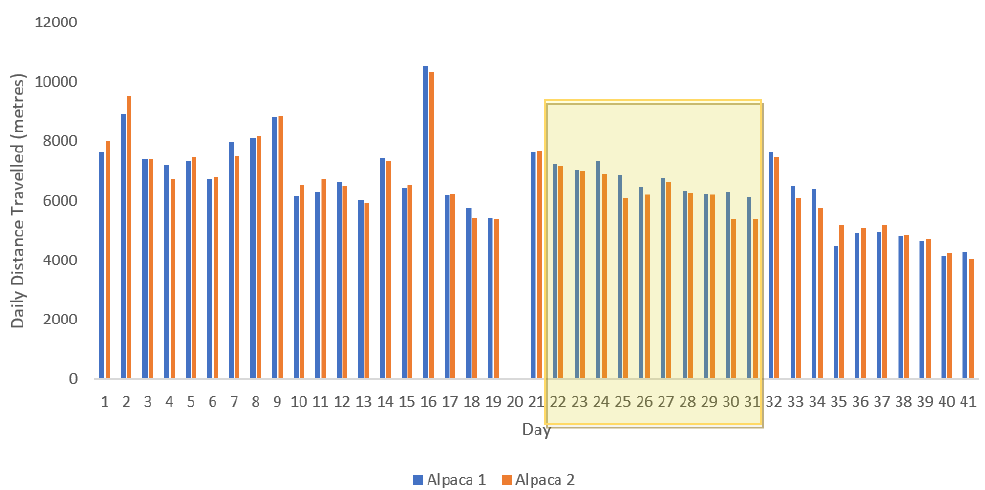
Figure 2. Daily distances (m) travelled by each alpaca over the 41-day testing period (day 20 shows no data due to collar change). Yellow shaded area highlights the 10-day observation period.